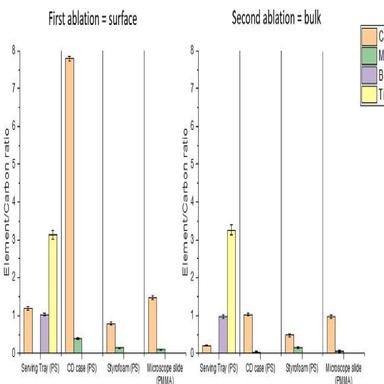
Element-to-carbon ratio of three different polystyrene samples and the PMMA sample detected with ICP-OES of the two-layered consecutive ablation processes.